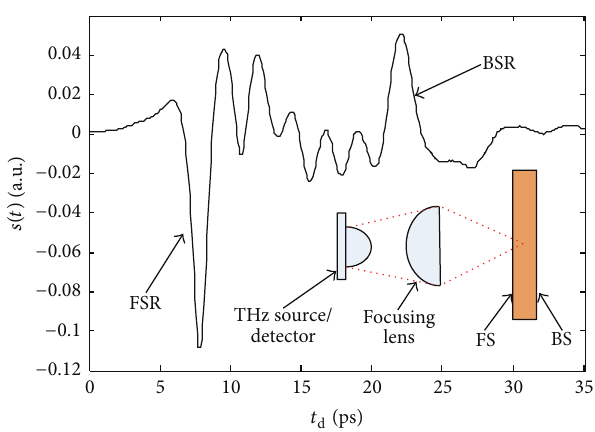
Figure 3: Exemplary A-scan signal 𝑠(𝑡) acquired over thin basalt fiber sample without defects: FSR: pulse caused by front surface reflection; BSR: pulse caused by back surface reflection.